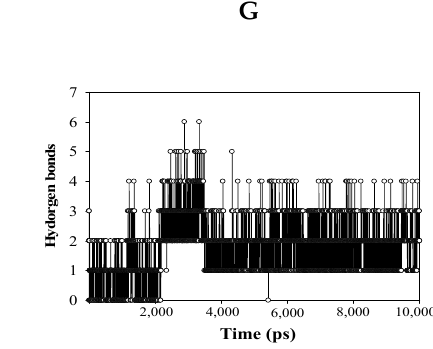
Figure 4. Superpositions of sEH with compounds 1 and 4 for simulation trajectory (0 ns: red, 1: orange, 2: yellow, 3: green, 4: forest green, 5: cyan, 6: blue, 7: cornflower blue, 8: purple, 9: hot pink, and 10: magenta) ( A , B ). The potential energy ( C ), root mean square deviation (RMSD) ( D ), root mean square fluctuation (RMSF) ( E ), and hydrogen bonds ( F , G ) of the simulation calculated with 1 and 4 during 10 ns. Table 3. Hydrogen bond analysis of the inhibitor with sEH at 1-ns intervals for 10